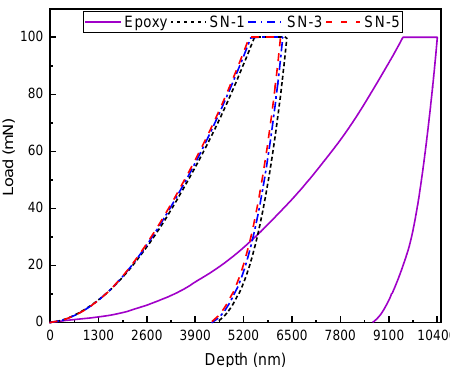
Figure 3. Load vs. depth cures of unmodified and SiO 2 modified coatings.